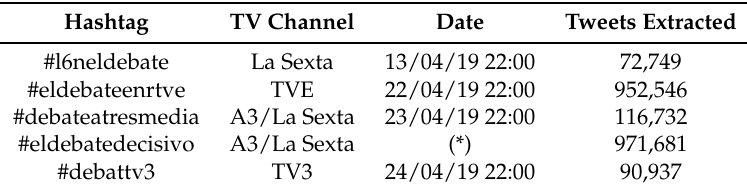
Table 3. Summary of the debates’ hashtags. (*) Note that #eldebatedecisivo was not the hashtag for the debate but was widely used for the talk-shows that discussed its